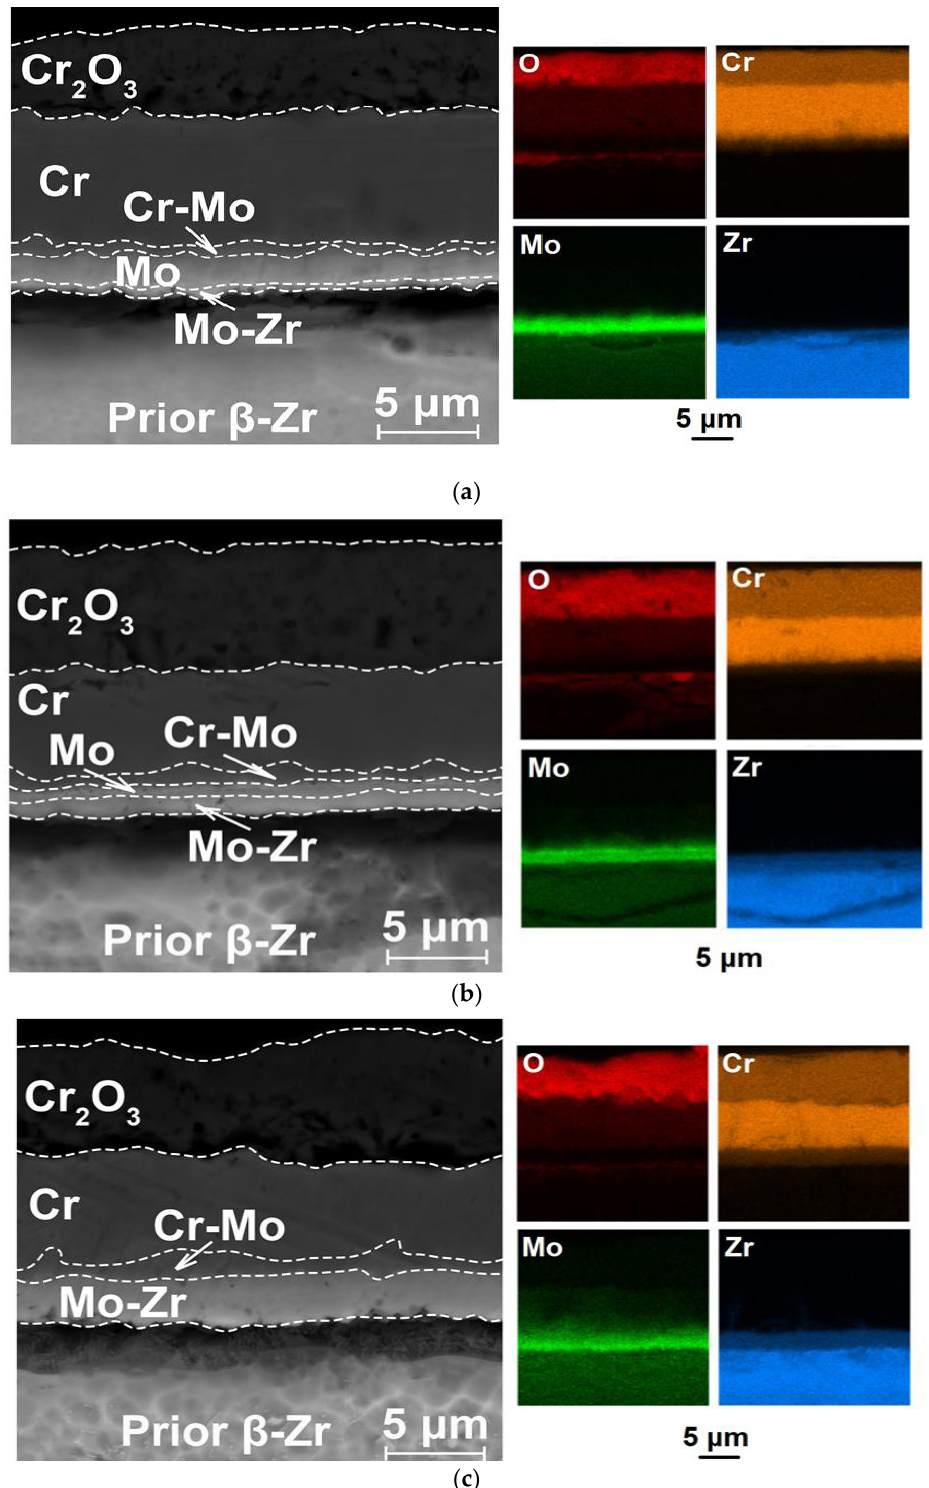
Figure 8. SEM images and EDS elemental distribution maps of the Cr/Mo-coated Zr alloy samples after LOCA oxidation at 1330 °C for 120 ( a ), 300 ( b ), and 720 s ( c ). Oxidation at 1400 ◦ C. LOCA oxidation at the supercritical temperature of 1400 ◦ C for 120 s leads to a significant change in the microstructure and elemental composition of the samples (Figure 9). The cross-section SEM image shows the formation of a six-layer structure: 1—thin outer Cr 2 O 3 layer, 2—ZrO 2 oxide layer (~33 µ m); 3— α -Zr(O)